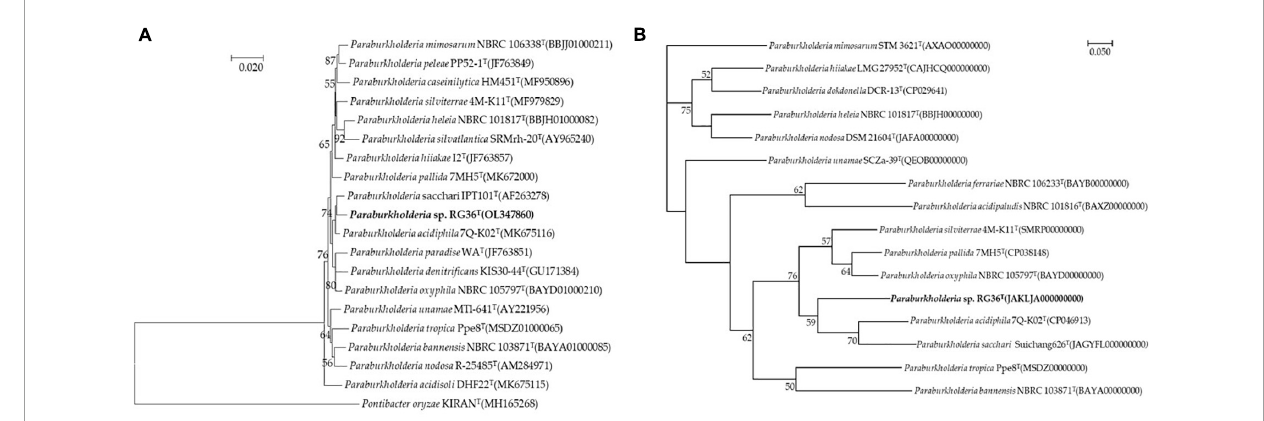
FIGURE1 Neighbor-joining tree based on 16S rRNA gene sequences showing the relationship between strain RG36 T and related species. Pontibacter oryzae KIRAN T (MH165268) was used as an out-group. Bootstrap values (based on 1,000 replications) greater than 50% are shown at branch points. Bar, 0.020 substitutions per nucleotide position (A) . Phylogenomic tree of strain RG36 T and closely related strains based on core genomes was constructed using UBCG, all genomes of 15 related strains were available on NCBI GenBank. GenBank accession numbers are shown in parentheses. Bootstrap analysis was carried out using 100 replications. Percentage bootstrap values ( > 50%) are given at branching points. Bar, 0.050 substitution per position (B)